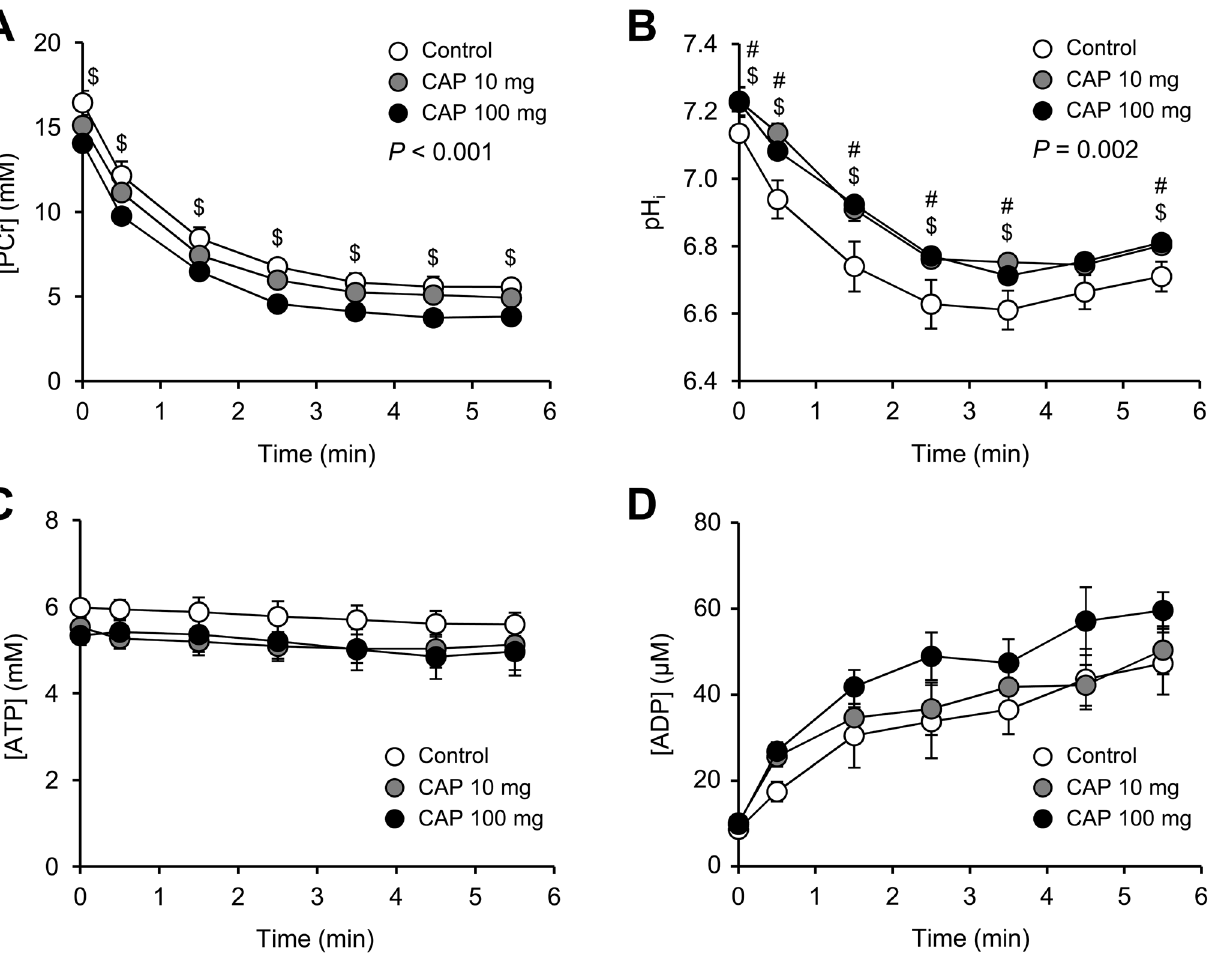
Fig 2. Phosphorylated compounds and pH in mouse gastrocnemius muscle in vivo. Changes in gastrocnemius muscle [PCr] (A), intracellular pH (B), [ATP] (C) and [ADP] (D) throughout the 6-min fatiguing electrostimulation protocol performed at the end of 2-week treatment with vehicle (control) or capsiate (CAP) at 10- or 100-mg/kg body weight. The first time point (t = 0) indicates the resting value. Data are means ± SEM. P -value indicates the overall result of the two-way repeated measures ANOVA. When justified ( P -value < 0.05), Tukey post-hoc multiple comparison was used for determining pairwise differences between groups: # Significant difference between CAP 10-mg and control. $ Significant difference between CAP 100-mg and control.